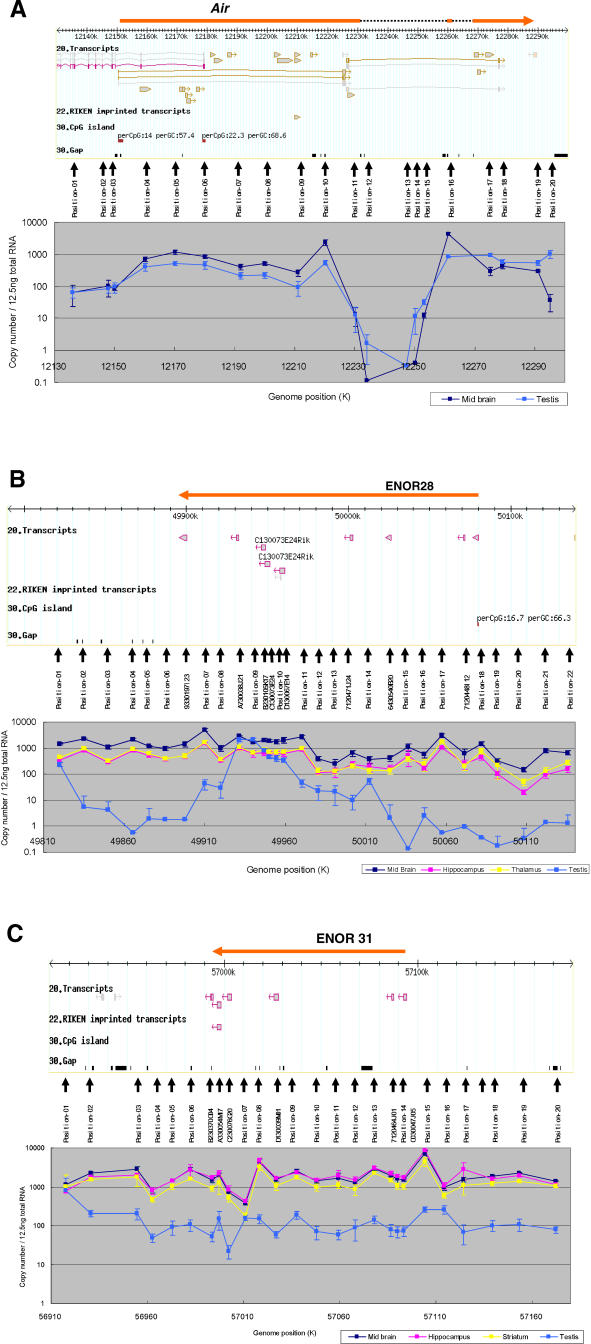
qRT-PCR AnalysisAnalysis of (A) Air, (B) ENOR28, and (C) ENOR31 loci. Above in each panel, screen shots of the GEV featuring the loci around Air, ENOR28, and ENOR31 are shown. The orange bars indicate the regions for Air, ENOR28, and ENOR31. cDNA sequences from the RIKEN and public databases are shown. Sequences mapped on the plus strand and minus strand are brown and purple, respectively. Predicted genes from Ensembl, NCBI, and RefSeq databases are shown in gray. For RIKEN imprinted transcripts, imprinted cDNA candidates identified previously [38] are shown. CpG islands as defined by the UCSC Genome Browser are shown. Positions of primer pairs are marked by small vertical arrows. Below in each panel, qRT-PCR results for midbrain, hippocampus, thalamus, striatum, and testis using the corresponding primer pairs are shown.